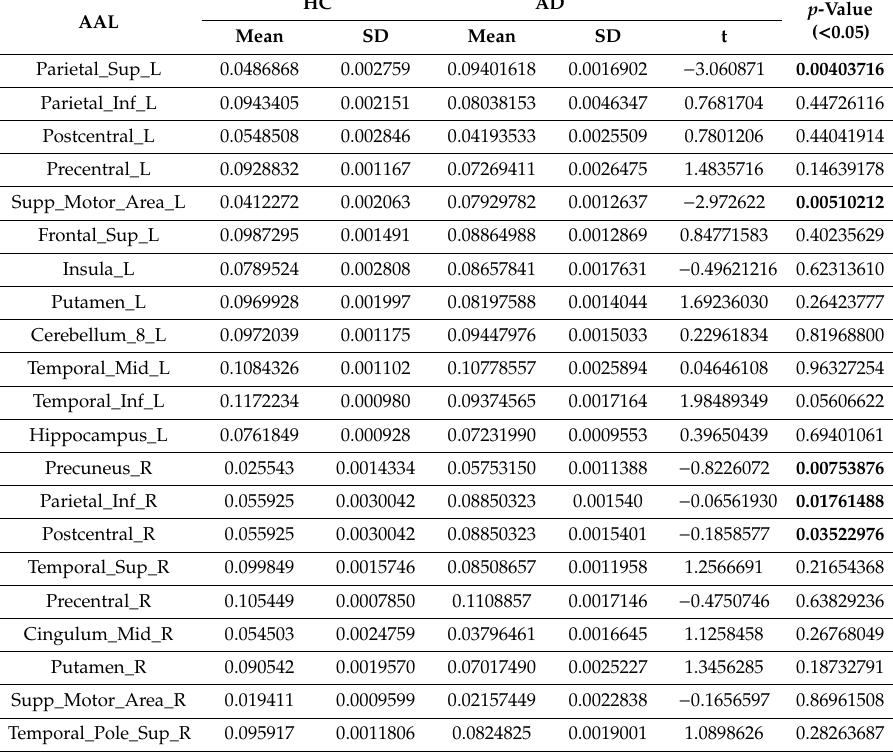
Table 2. Region-of-interest-based clustering coe ffi cient changes between HC and